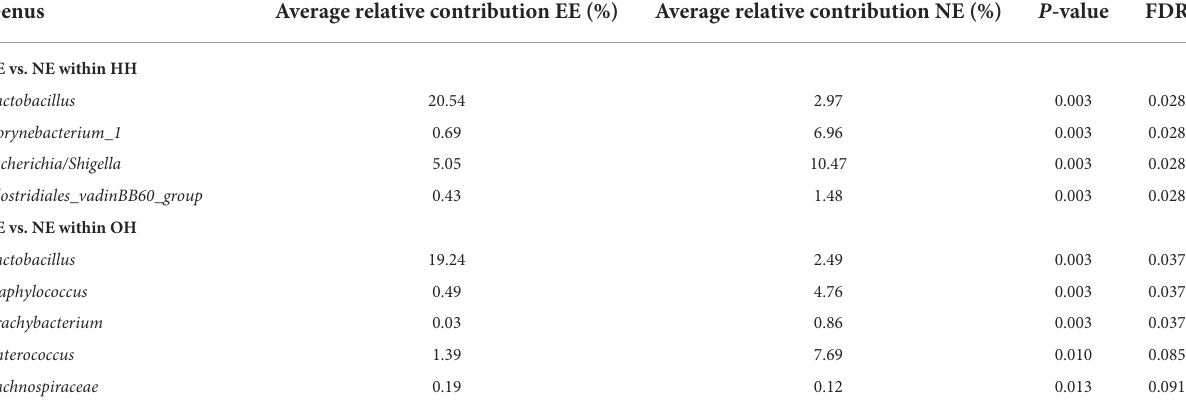
Genus Average relative contribution EE (%) Average relative contribution NE (%) P -value